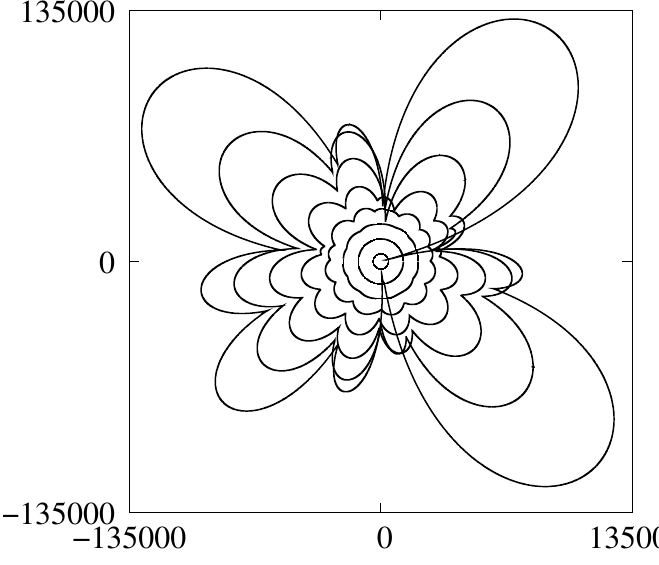
Figure 4. Flame speed D = R